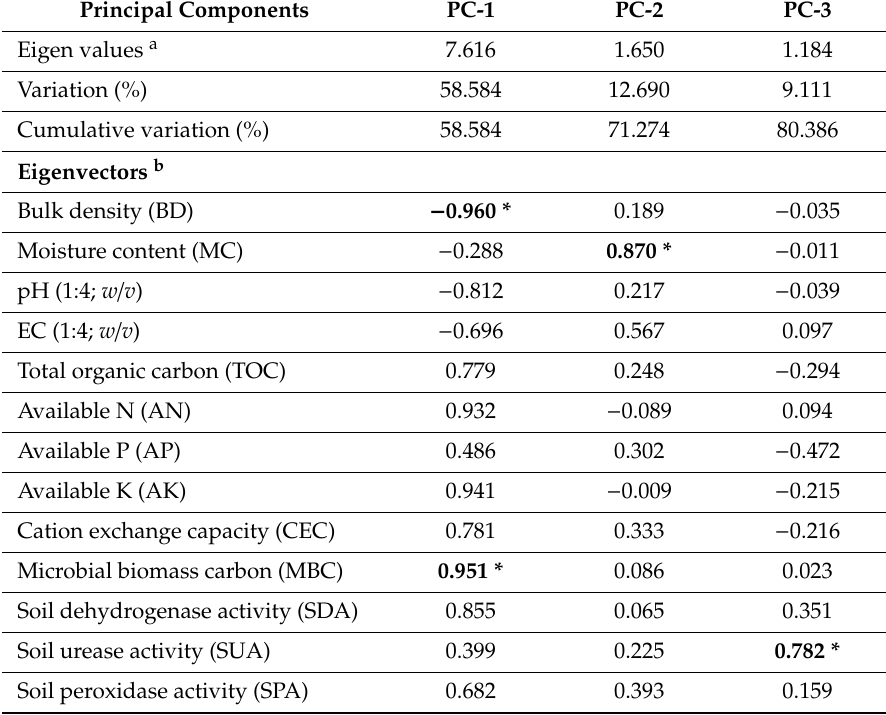
Table 4. Results of the PCA of rhizosphere soil parameters under D. sissoo growth in the degraded land of Barkachha of Mirzapur district in Uttar Pradesh.